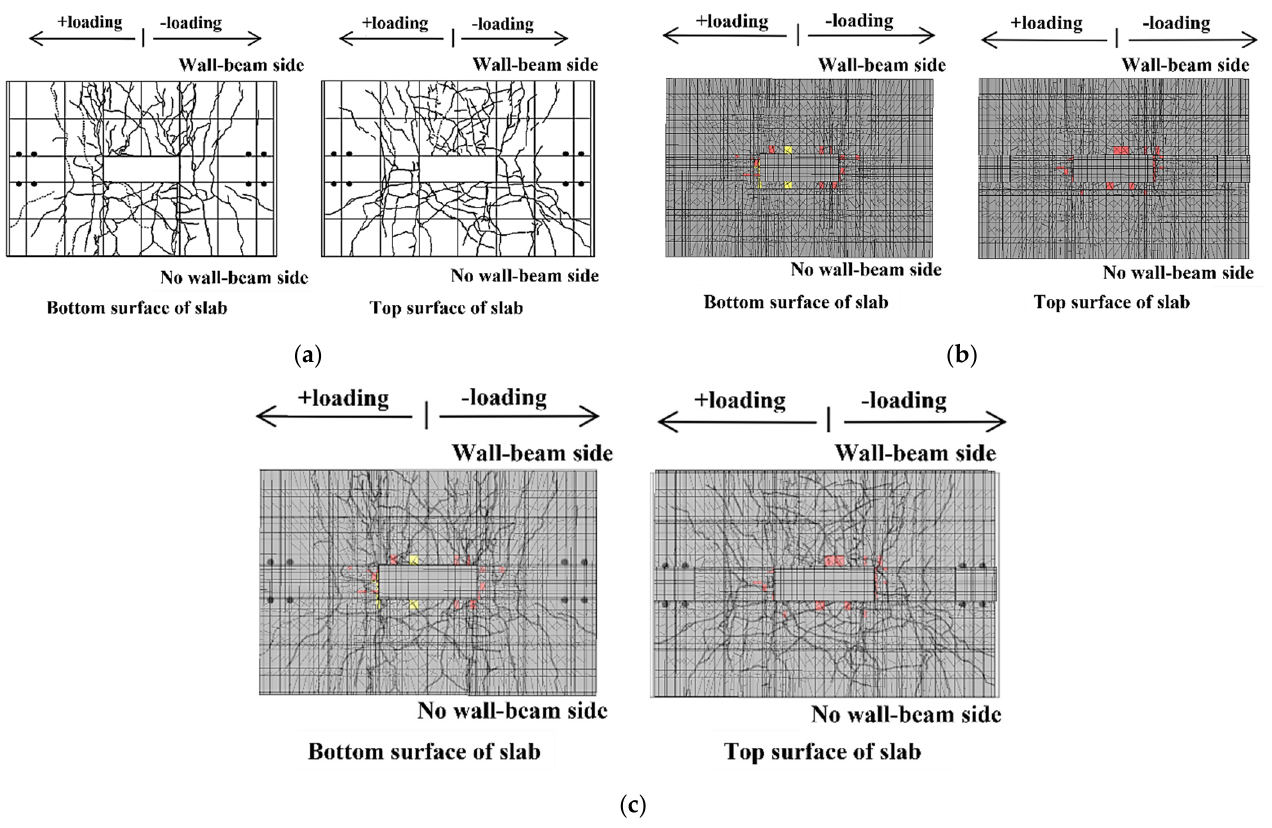
Figure 17. Crack pattern comparison of experimental and FEM results for Model 2: ( a ) Experimental test results [11,12]; ( b ) FEM analysis results; and ( c ) comparison.